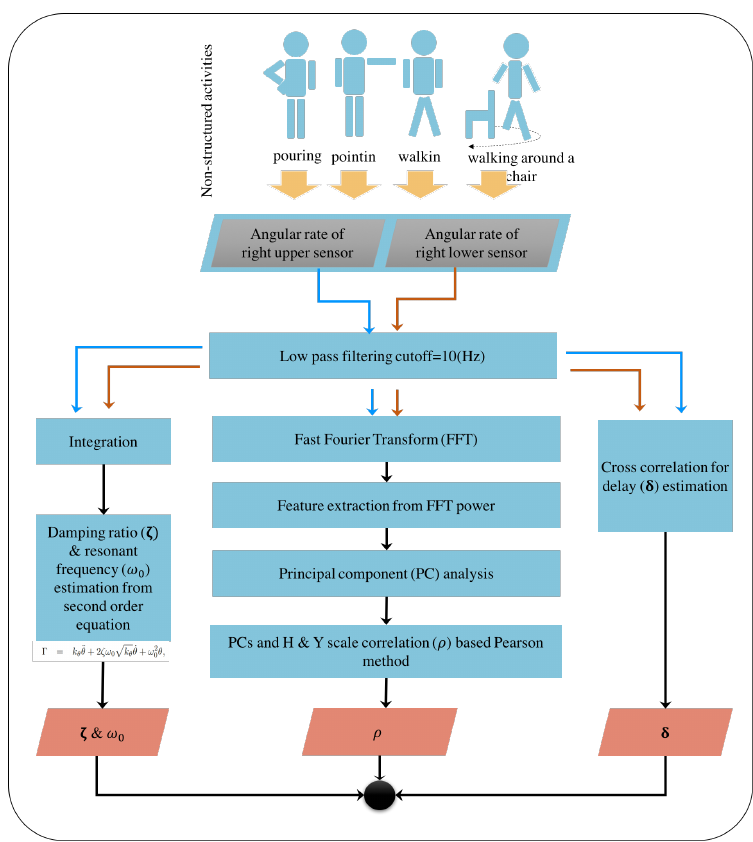
Figure 3. Unstructured activity analysis for Parkinsonian features: Blue arrows represented the sequence of the upper sensor data processing; red arrows represented the sequence of the lower sensor data processing; and black arrows represented the common sequence of both upper and lower sensor